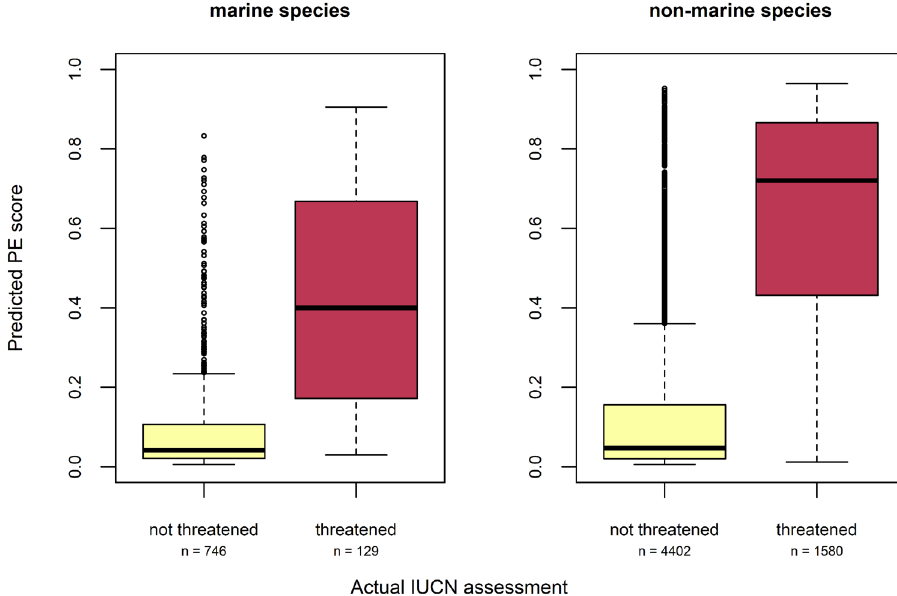
Fig. 1 Predicted scores for threatened versus not threatened species. Boxplot showing the interquartile range (box), median (black line), minimum and maximum values without outliers (error bars), and outliers (points) of predicted probability of being threatened by extinction (PE score) across the actual IUCN assessment (not threatened and threatened) for marine ( n = 875) and non-marine ( n = 5982) species in the set-aside testing data.